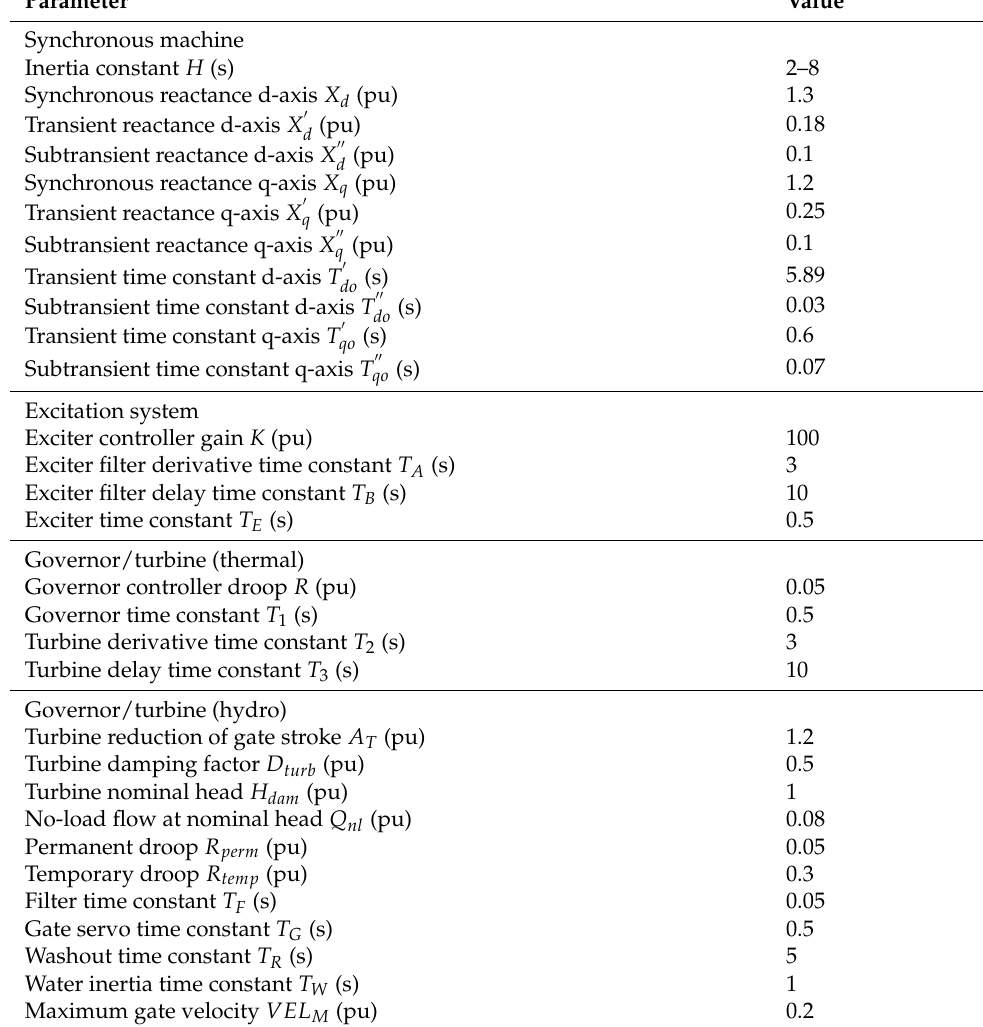
Table 3. Main parameters of the Colombian interconnected national